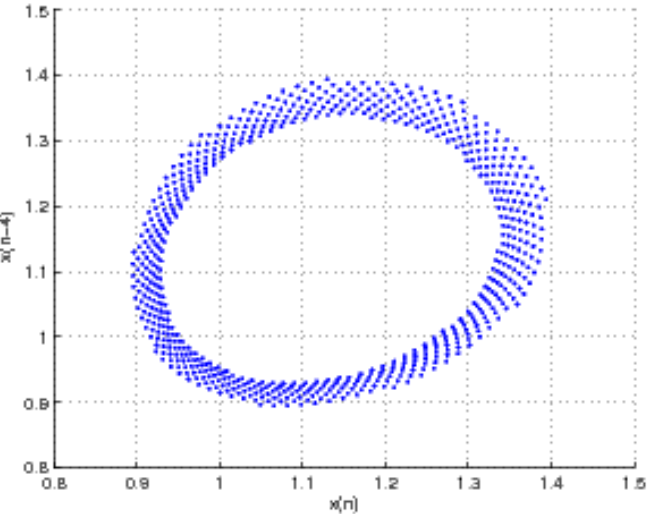
Figure 5. Phase portraits of the map x n + 1 = x n + x n − 4 /0.889 + x n − 1 for B = B ∗